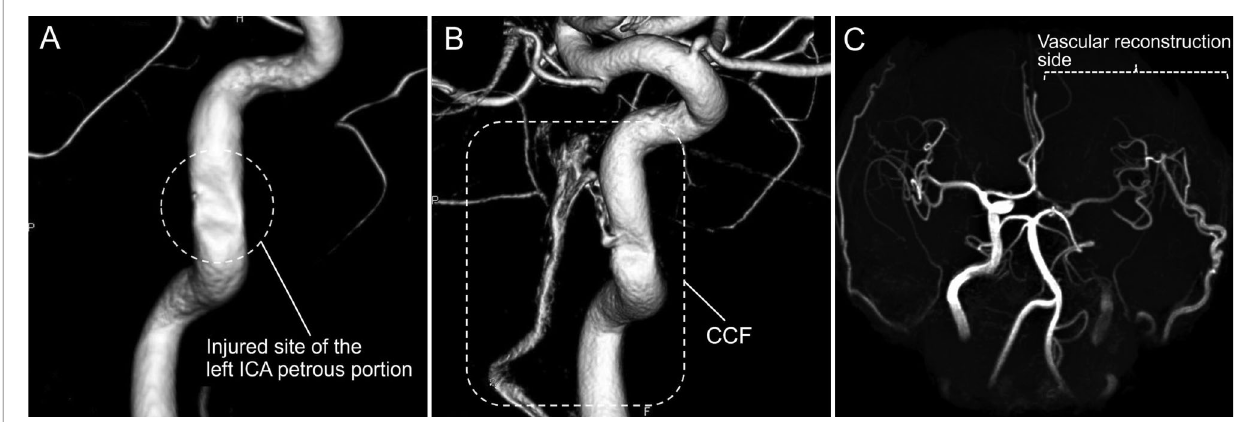
FIGURE 3 | ( A ) Three-dimensional cerebral angiography of the left internal carotid artery (ICA) immediately after surgery showing no extravasation from the injured site of the left ICA petrous portion. ( B ) Three-dimensional cerebral angiography of the left ICA following balloon de fl ation 7 days after surgery revealing carotid- cavernous sinus fi stula (CCF) originating from the injured site of the left ICA petrous portion. ( C ) Postoperative magnetic resonance angiography showing the success of vascular reconstructive surgery combined with internal coil trapping of the left